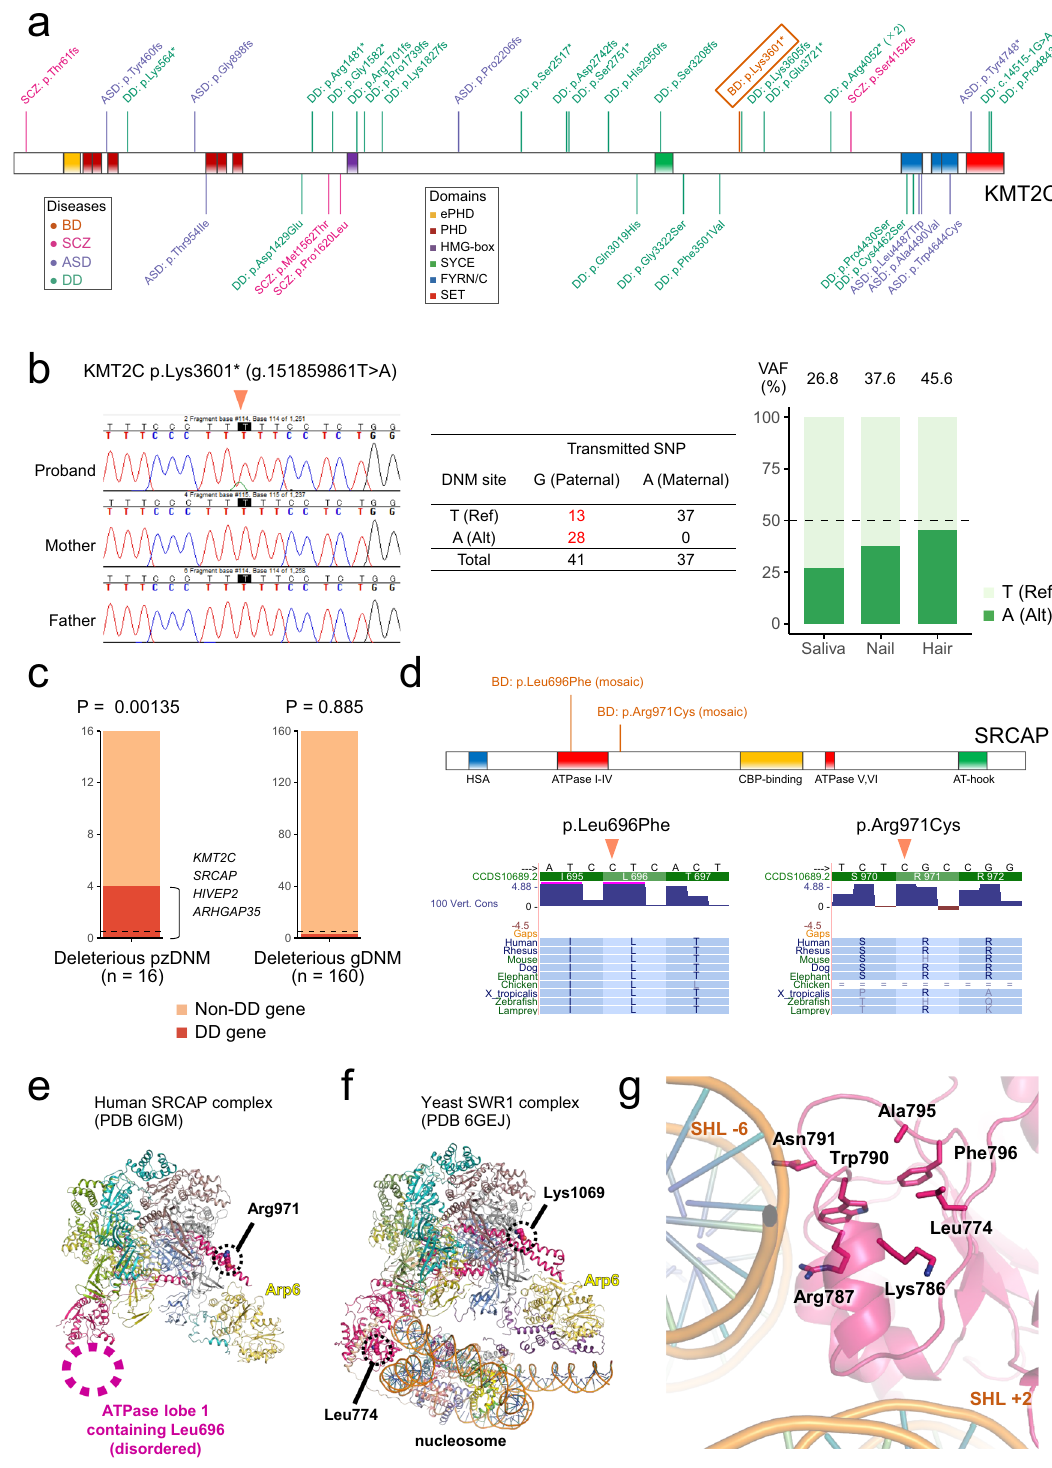
Gaps Human Rhesus Mouse